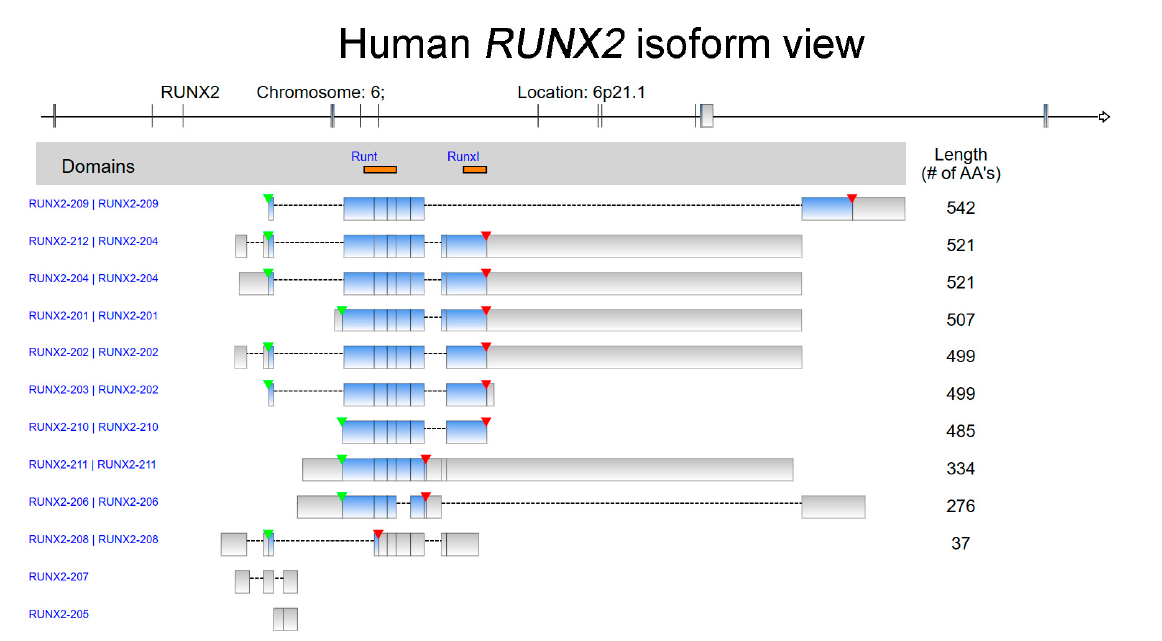
Figure 1. The isoform view of human RUNX2 . The red and green arrowheads show the positions of the stop codon and transcription start site, respectively. In addition, the matched protein domains in each isoform are marked in orange. Runt: Runt domain. RunxI: Runx inhibition domain. The information is based on the data adapted with permission from Ingenuity Pathway Analysis. Copyright Year 2023, QIAGEN.